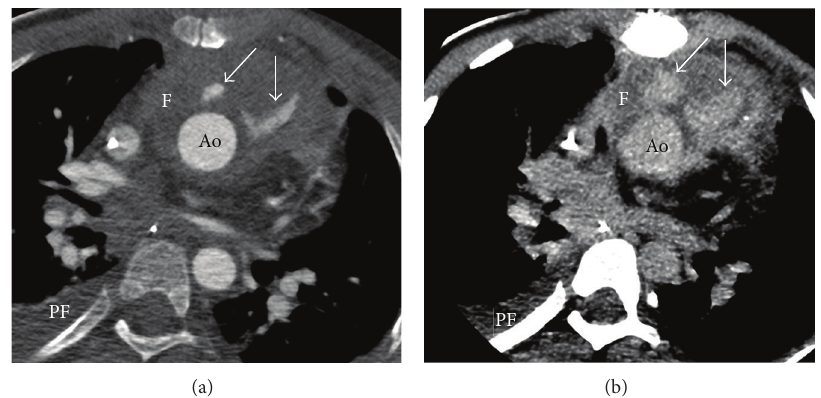
Figure 2: Active blood extravasation due to suture leakage. Same patient as in Figure 1 showing active extravasation of contrast (which is leakage of blood, arrows in (a) and (b)) ventral to the aorta (Ao) caused by suture leakage during chronic mediastinitis. Note accumulation of blood during delayed imaging (arrows, (b)). F: mediastinal fluid; PF: pleural fluid. Effective dose 𝐸 = 0.8